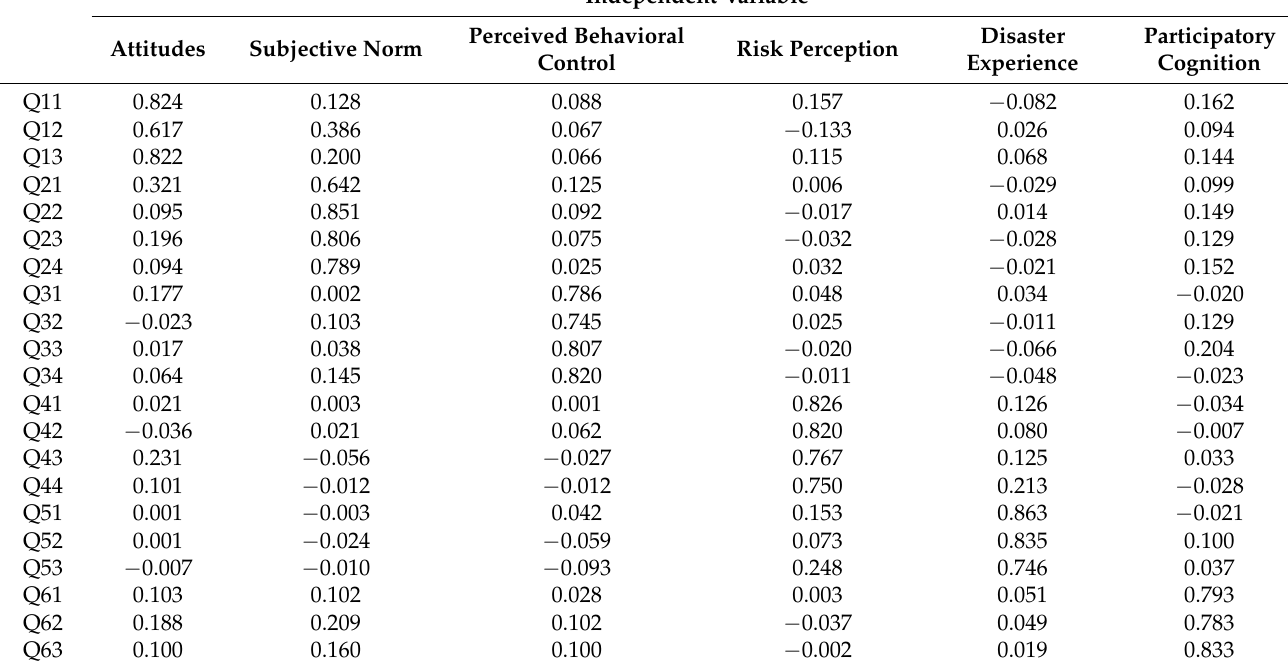
Table 2. Rotated component matrix.